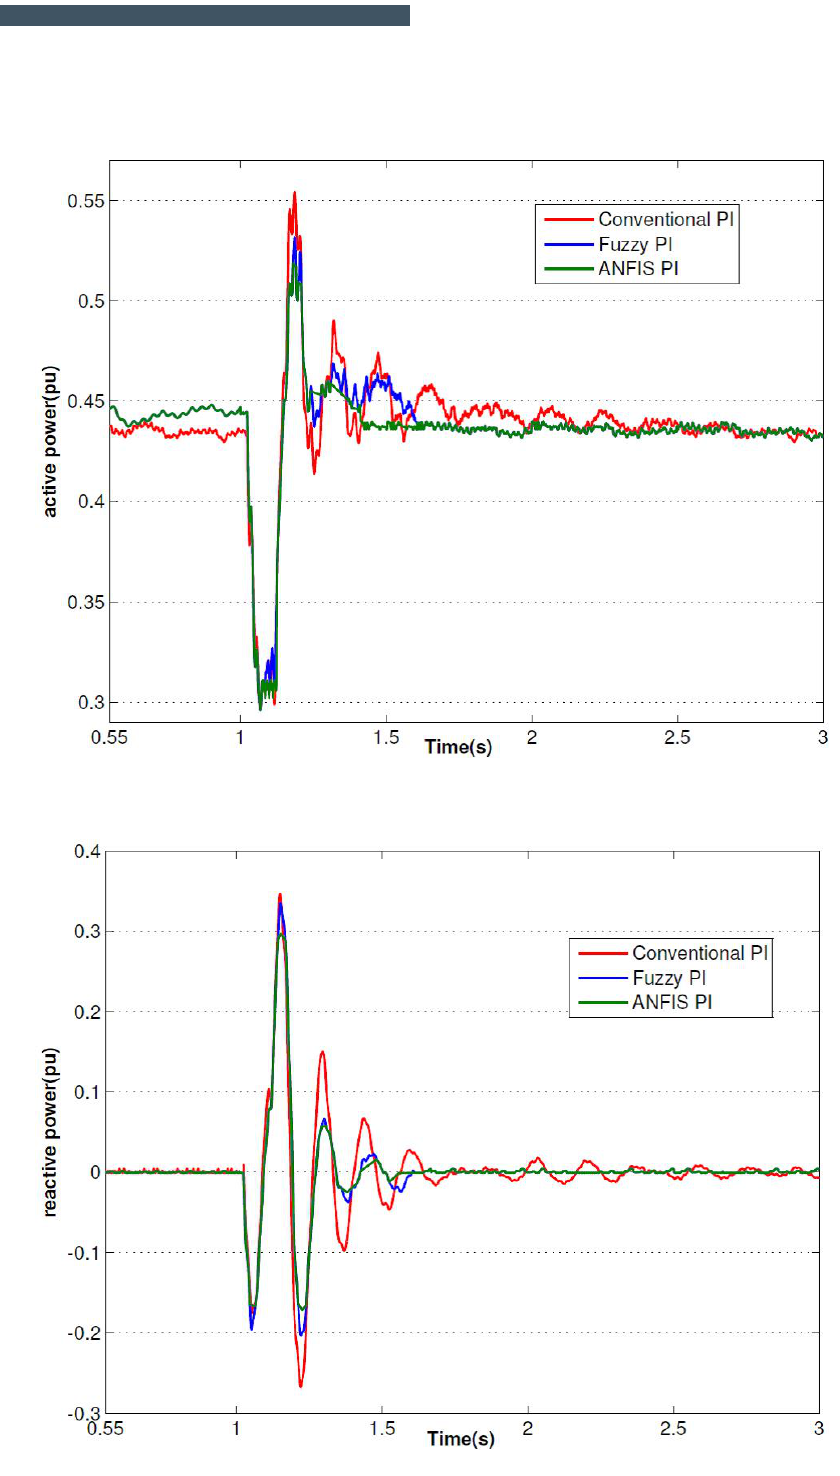
Figure 6. (a) Active power (b) reactive power at rectifier AC bus for a 5 cycle line to ground fault on inverter side AC